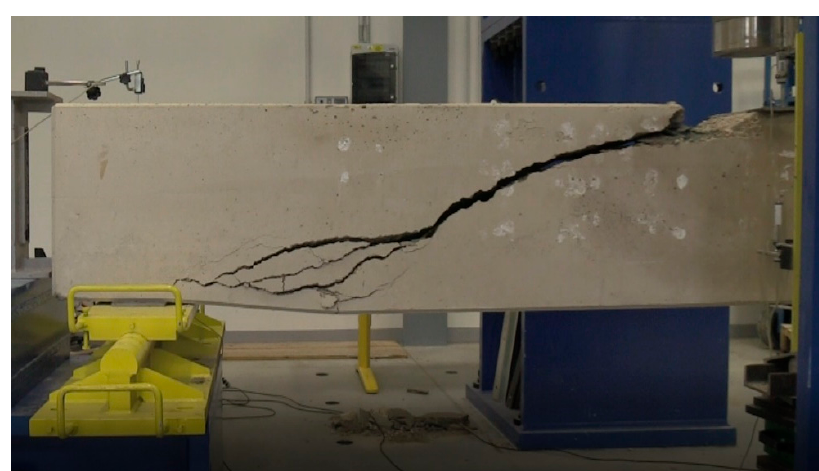
Figure 6. Reinforced concrete (RC) beams with transverse reinforcement (A1)—experimental program for alkaline-activated material (AAM).